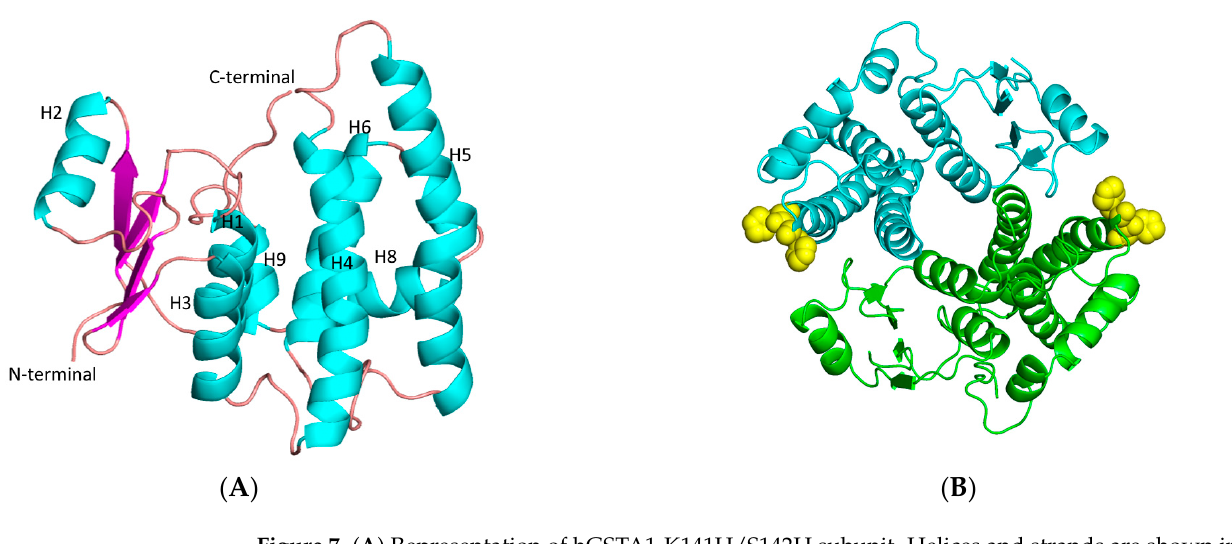
Figure 7. ( A ) Representation of hGSTA1-K141H/S142H subunit. Helices and strands are shown in cyan and magenta, respectively. The helices are labeled. ( B ) Representation of hGSTA1-K141H/S142H dimer from the top. The two-fold axis that relates the two molecules is perpendicular to the plane of the paper. The histidine amino acids at positions 141 and 142 are shown as yellow spheres. The figures were created using PyMOL Molecular Graphics System [30]. Table 5. X-ray data collection and refinement